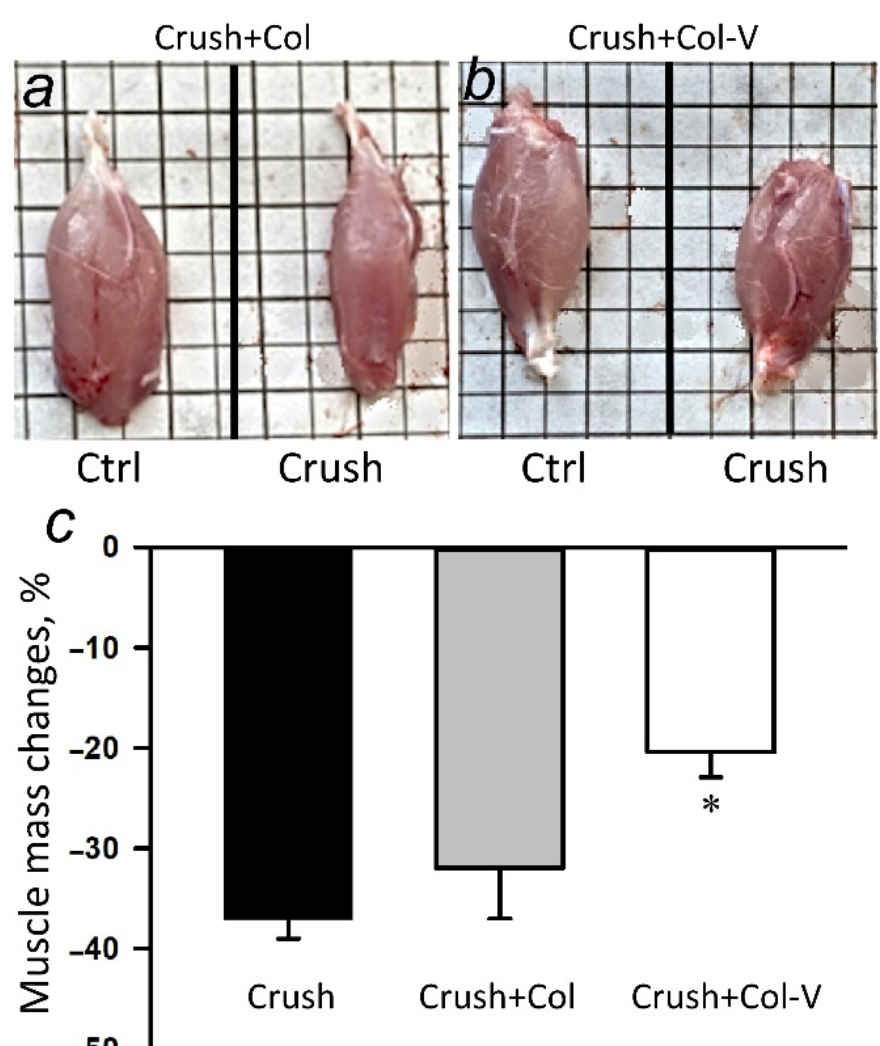
Figure 2. Weight loss of the gastrocnemius muscle of the injured limb relative to the weight of the muscle of the intact limb 30 days after sciatic nerve crush. ( a ) Left, view of the intact limb muscle (Ctrl); right, view of the muscle 30 days after the sciatic nerve crush (Crush). ( b ) Left, view of the intact limb muscle (Ctrl); right, view of the muscle 30 days after sciatic nerve crush and application of collagen–vesicle preparation 1 h after injury (Crush). ( c ) Change in gastrocnemius muscle mass 30 days after sciatic nerve crush (Crush), application of collagen gel (Crush+Col) and collagen–vesicle preparation (Crush+Col-V) in % relative to the contralateral muscle mass. M ± SEM; n = 8 (the number of animals in each experimental group); * p < 0.05 as compared to the group with crushing without treatment (Crush), One-Way ANOVA with Tukey’s post hoc test. Another parameter of atrophy is a decrease in muscle fiber diameter. Our studies showed that a single application of collagen gel to the site of nerve damage affected the diameter of the muscle fiber; this parameter in the group with collagen treatment was 19.3% ( p ≤ 0.05) higher than in the group with crushing alone. The application of vesicles as part of the collagen gel increased the diameter by 33.3% ( p ≤ 0.05) relative to the group with crushing (Figure